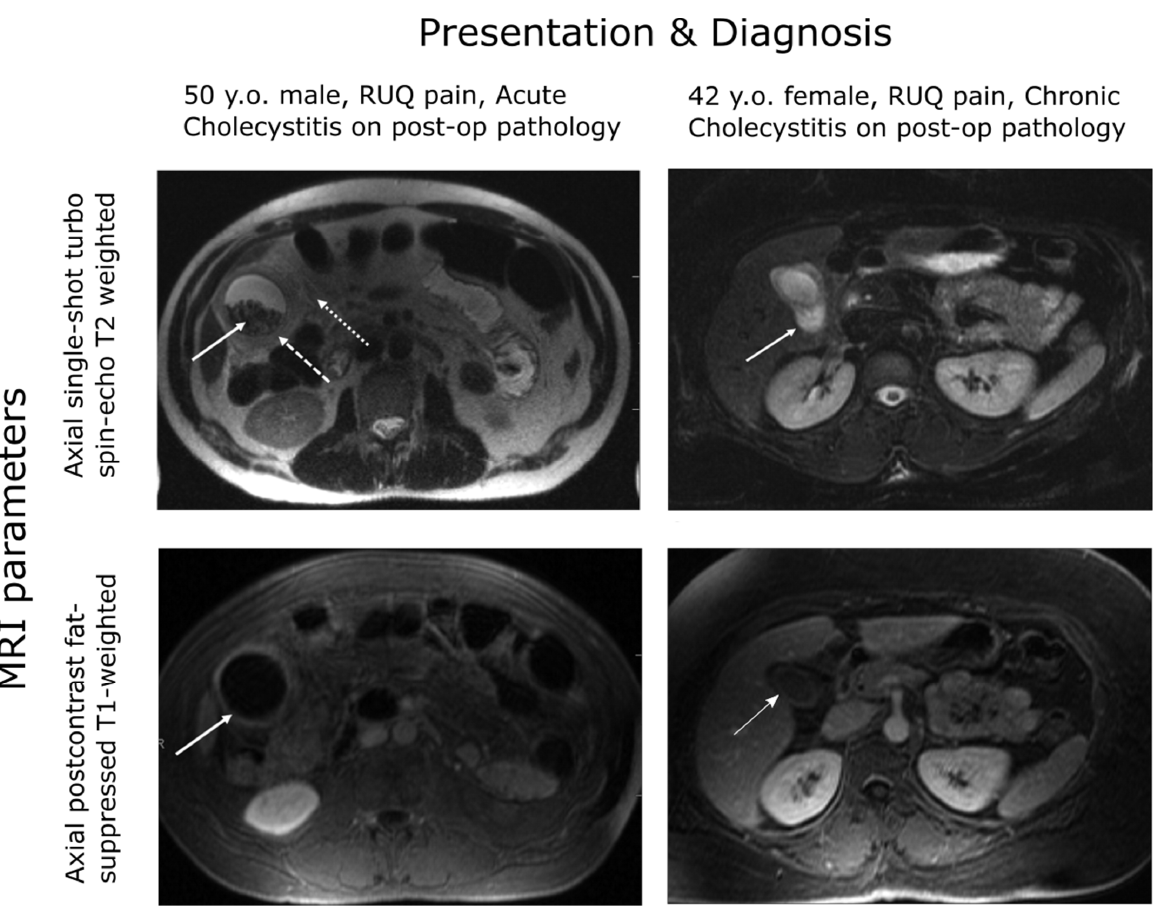
Figure 1. MRI gallbladder imaging. Wall thickening is evident for both the chronic and acute pa- tients but enhanced under contrast only for the acute patient. [77] but enhanced under contrast only for the acute patient